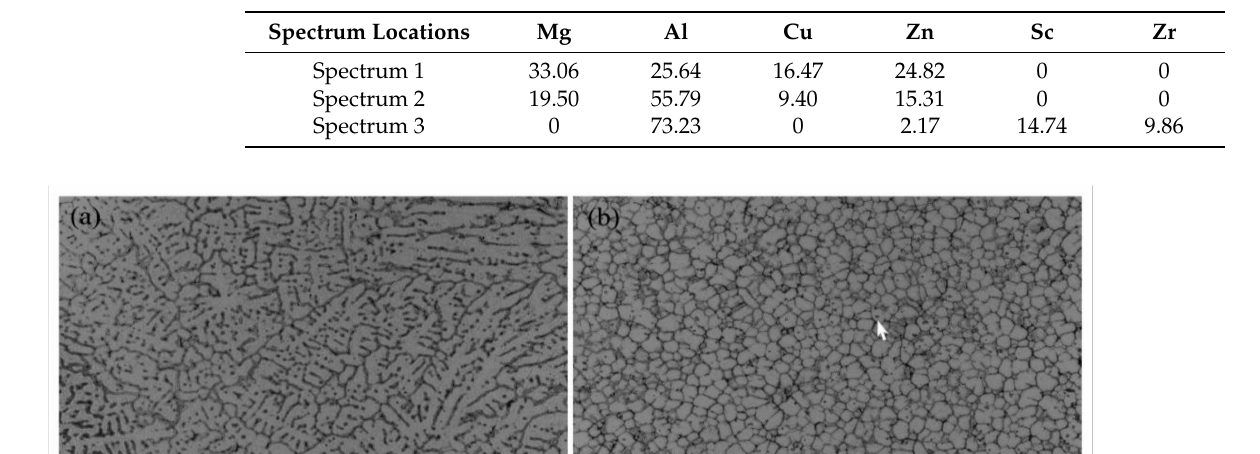
Table 2. EDS analysis results of secondary phases (in at.%).